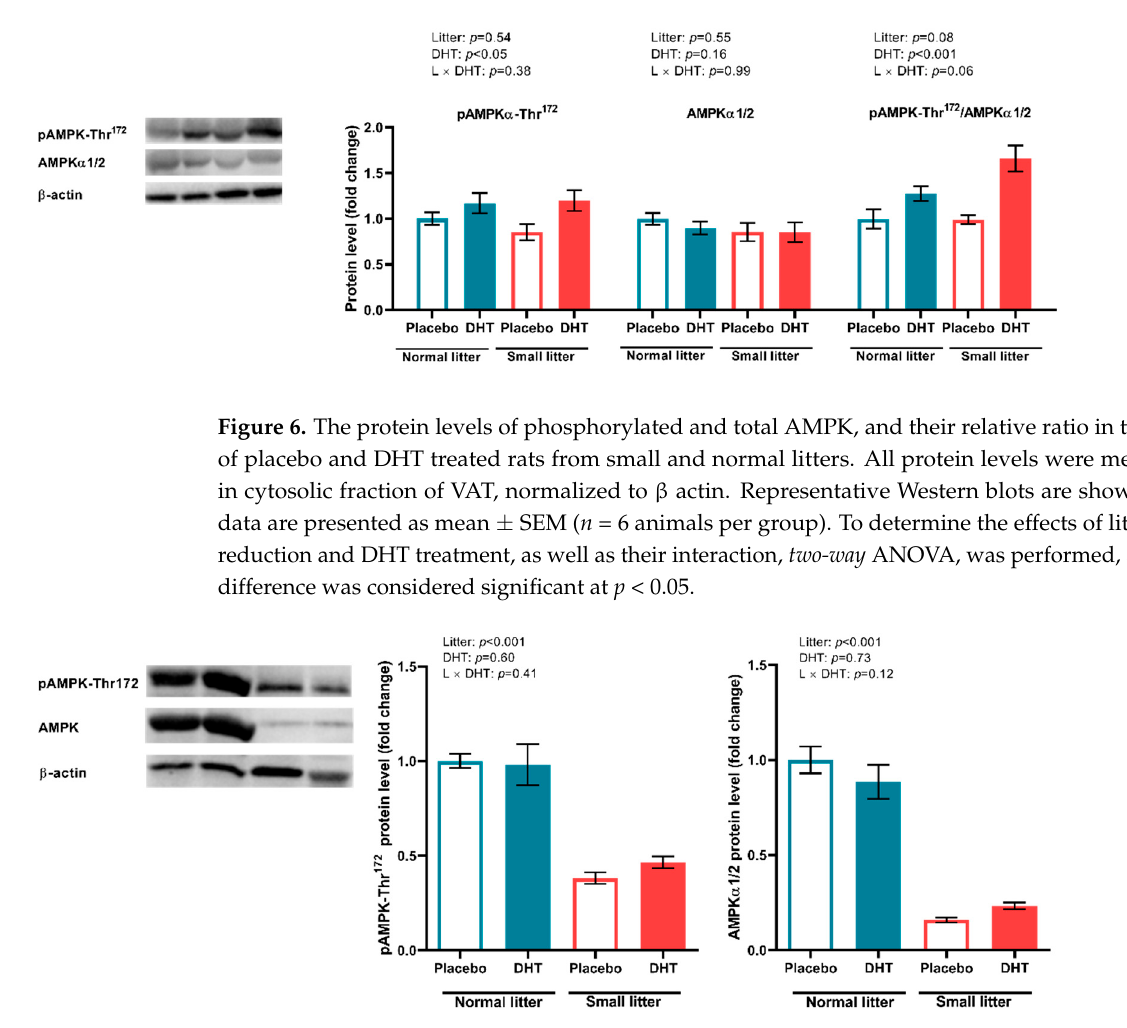
Figure 7. The protein levels of phosphorylated and total AMPK in the SAT of placebo and DHT treated rats from small and normal litters. All protein levels were measured in total protein extract, normalized to β actin. Representative Western blots are shown. The data are presented as mean ± SEM ( n = 6 animals per group). To determine the effects of litter size reduction and DHT treatment, as well as their interaction, two-way ANOVA was performed, and the difference was considered significant at p < 0.05.